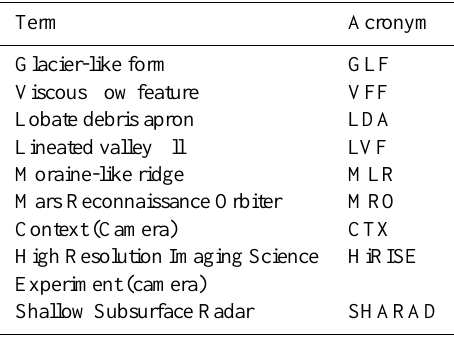
Figure 2. The spatial distribution of Mars’ 1309GLFs as identified by Souness et al.